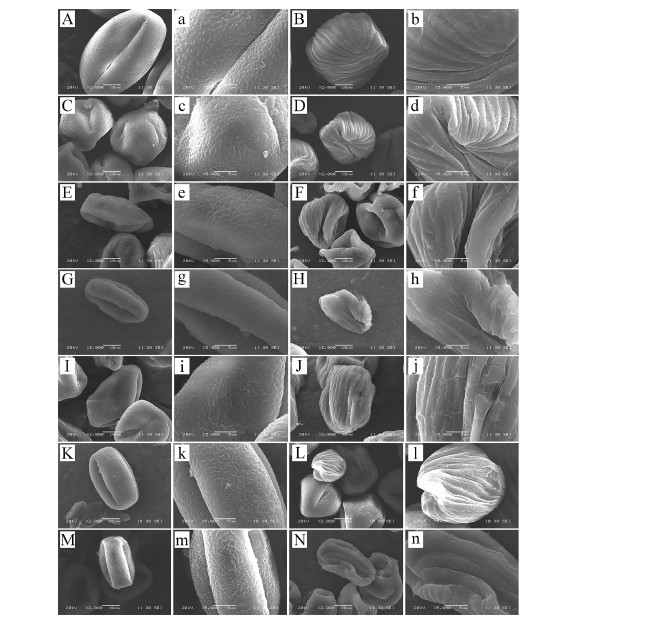
FIGURE 7 Normal pollen and pseudopollen of different species of Camellia under scanning electron microscopy. (A, B) Camellia hainanica. (C, D) Camellia meiocarpa. (E, F) Camellia brevistyla. (G, H) Camellia confusa. (I, J) Camellia hiemalis. (K, L) Camellia kissii. (M, N) Camellia obtusifolia . The two columns of pictures on the left are normal pollen, and the right are pseudopollen.